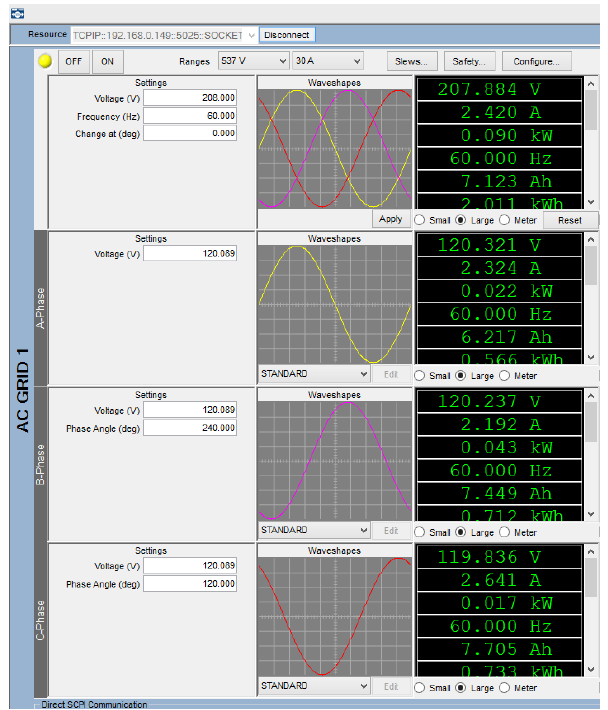
Figure 18. Hardware results using grid simulator NHR 9400 panel for real power = 0 W and reactive power = 0 var under balanced grid